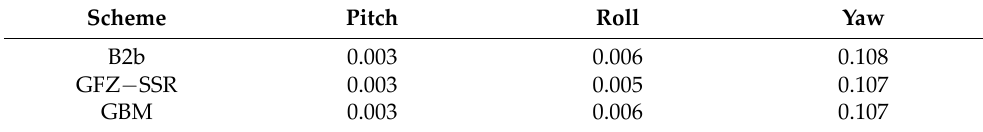
Figure 9. Attitude error of the three precise products using tactical IMU. Table 6. RMS statistics of attitude error for the three precise products using tactical IMU (unit: deg). Scheme Pitch